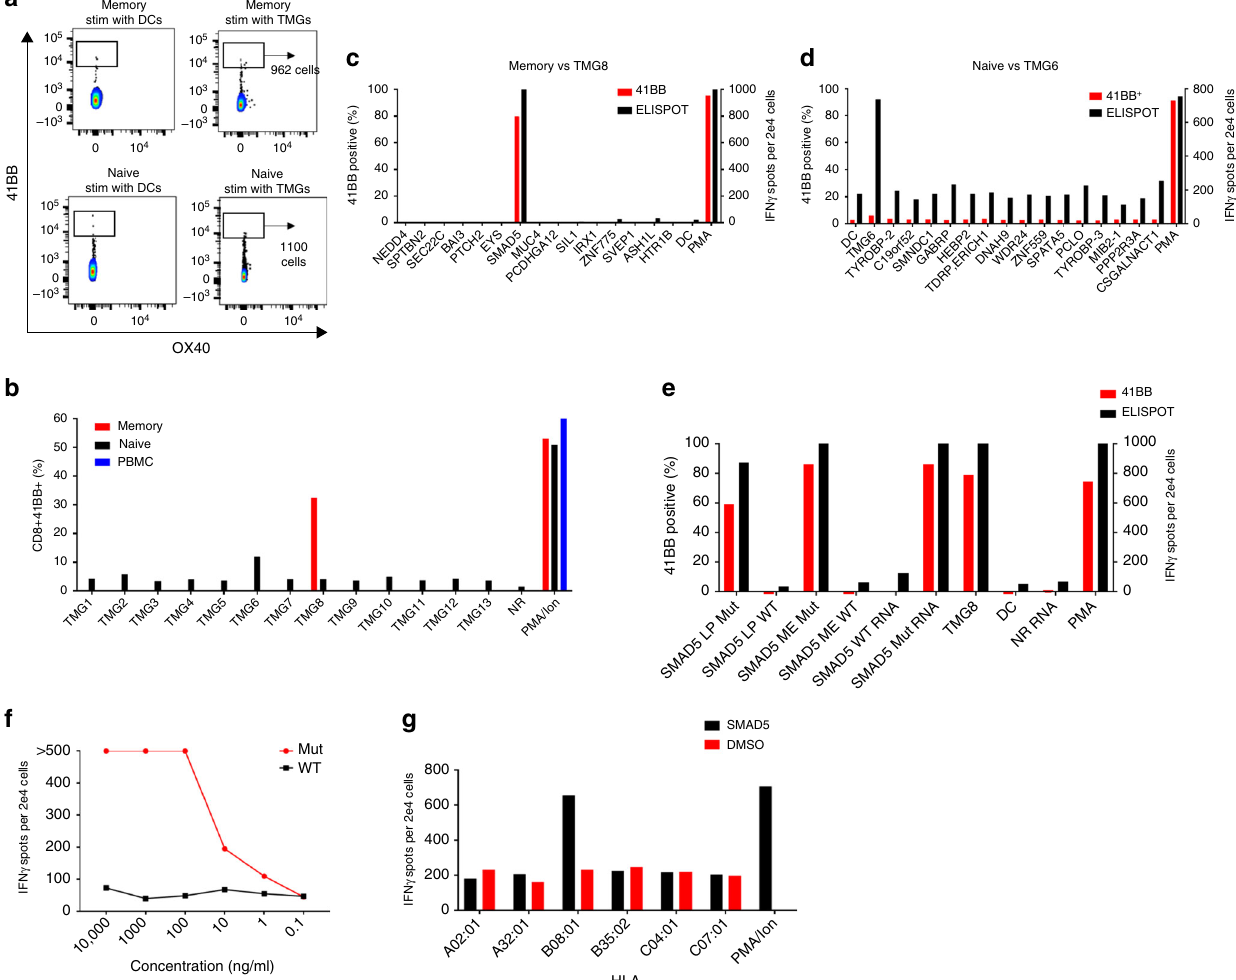
Fig. 2 Identi fi cation of T cells speci fi c for mut SMAD5. a Memory and naive CD8 cells were co-cultured with autologous DCs transfected with 13 TMGs harboring 201 mutated 25mer sequences for 18 h. Activated T Cells were stained for CD3, CD8, 41BB, and OX40 and sorted based on 41BB and OX40 expression to enrich for neoantigen-reactive cells. b Memory, T N and PBMC were co-cultured with autologous DCs transfected with TMGs 1 – 13 for 18 h, stained with CD3, CD8, and 41BB and analyzed for surface expression of 41BB as a marker for T-cell activation. c Memory CD8 cells isolated in A were co- cultured for 18 h with autologous DCs that were individually pulsed with the mutated peptides encoded by TMG-8 and tested either by fl ow cytometry for 41BB expression or IFN γ -secretion using ELISPOT assay. d Naive CD8 cells isolated in a were co-cultured for 18 h with autologous DCs that were individually pulsed with the mutated peptides encoded by TMG-6 and tested either by fl ow cytometry for 41BB expression or IFN γ -secretion using ELISPOT assay. e Memory CD8 cells isolated in a were co-cultured for 18 h with autologous DCs that were loaded with WT or Mut SMAD5 LP, predicted minimal epitope (ME) and full-length WT and mutated SMAD5 RNA. Cells were tested for antigen recognition by fl ow cytometry for 41BB expression or IFN γ - secretion using ELISPOT assay. f TCR-transduced PBLs were co-cultured with DCs pulsed with a serial dilution of SMAD5 Mutated or WT peptides. g COS7 cells were transfected with patient ’ s class I HLA and co-cultured with TCR-transduced cells. Reactivity was determined by ELISPOT for IFN